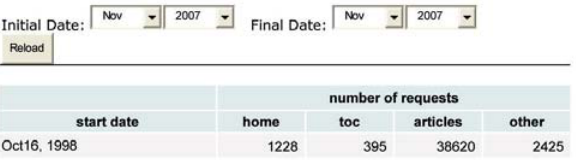
Fig. 4B - Gráfico com os acessos diários referentes ao mês